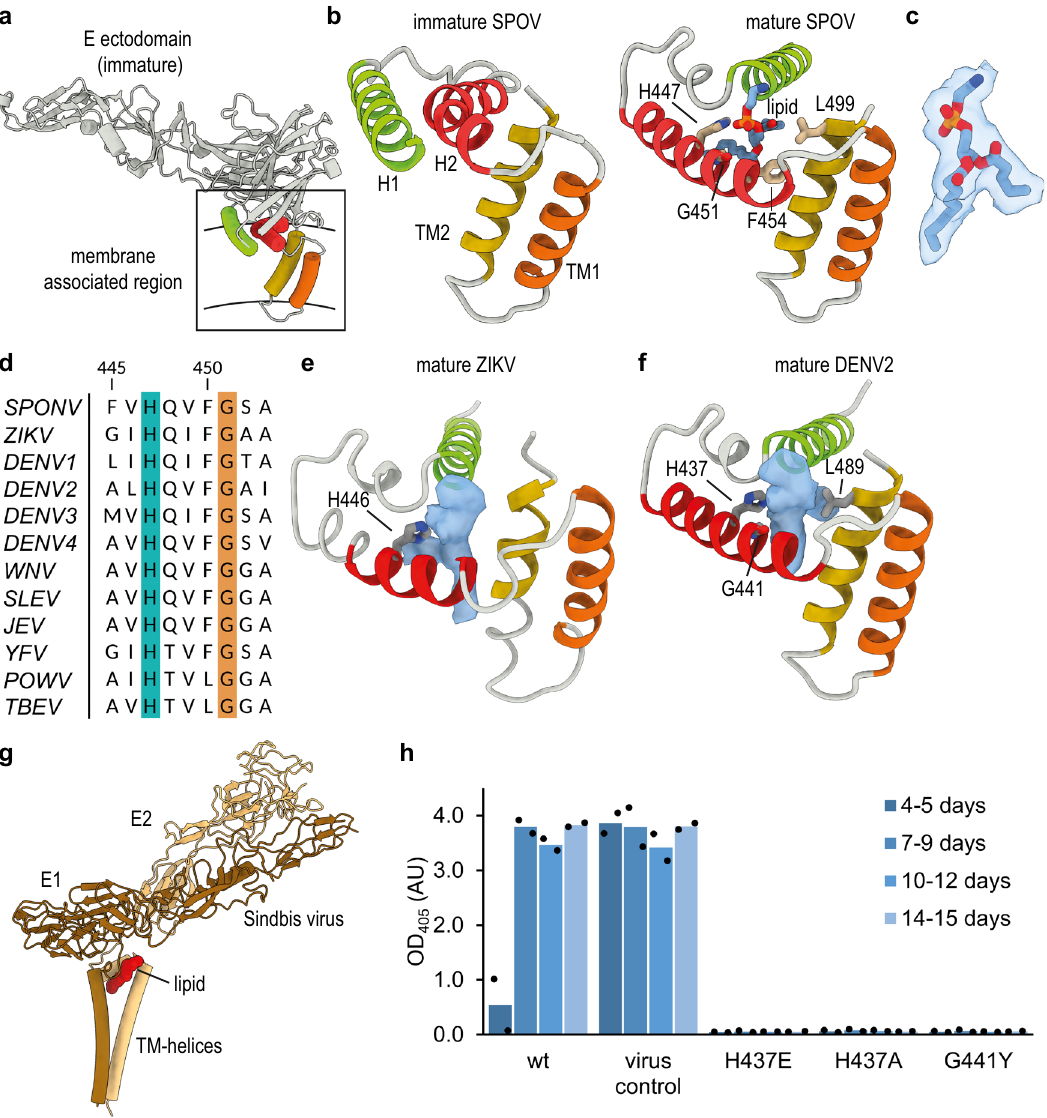
Fig. 4 Formation of a lipid pocket by rearrangement of membrane-associated helices. a Position and organization of membrane-associated helices in immature E. Two amphipathic helices lie fl at on the membrane (colored green and red), whereas two transmembrane (TM) helices span it (colored yellow and orange). b Close-up view of the membrane-associated helices of immature E and mature E of SPOV. Amphipathic helices are numbered H1 and H2, TM helices TM1 and TM2. In mature E (on the right), the amphipathic helices have reorganized, opening up a pocket that is fi lled with density resembling a phosphatidylethanolamine (PE) lipid. The lipid is shown in stick representation. The density fi t is shown separately in c for clarity. Residues in close vicinity are shown as sticks and labeled appropriately. c Lipid fi tted into the cryo-EM map at the binding pocket. d MSA of E sequences located next to the lipid, highlighting the conservation of H447 and G451 (SPOV numbering). Virus abbreviations as in Fig. 2. e Density present in the pocket of mature ZIKV (accession code: EMDB-7543). f Density present in the pocket of mature DENV2 (this study). g Structure of Sindbis virus E1 and E2 (PDB-ID: 6IMM) illustrating the similarity of the position of a glycoprotein associated lipid (colored in red). h Virus recovery after Gibson assembly of mutant viruses. Wild- type and mutants of DENV2/16681 were constructed via Gibson assembly and propagated in C6/36 cells. Production of virus was assessed after given intervals by ELISA. Cells infected with virus stock served as positive control. The results of n = 2 biologically independent experiments are